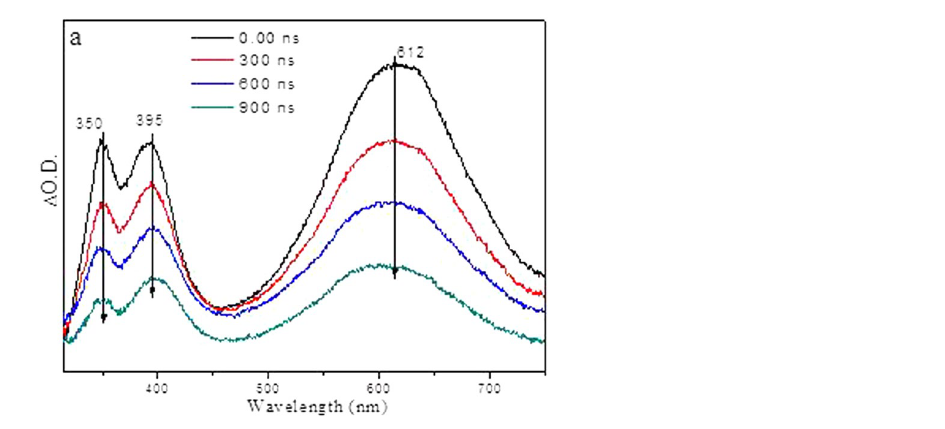
Figure 10. The ns-TA spectra of PPAQ in pH 2 MeCN-H 2 O (1:1) recorded with 266 nm excitation are